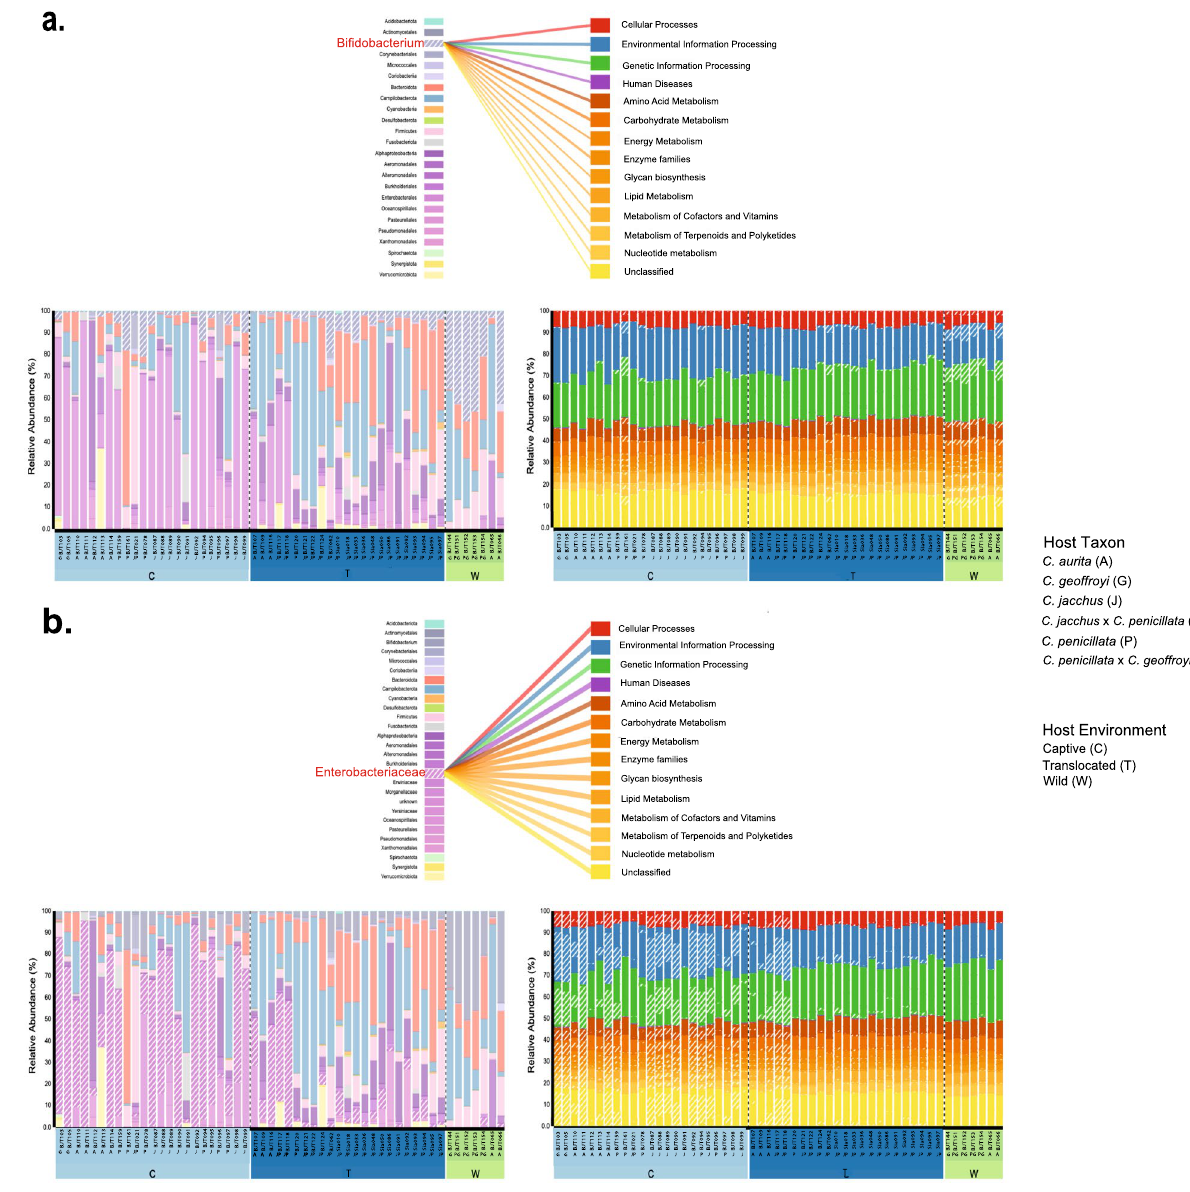
Figure 6. Visualization of BURRITO results showing linkage between Callithrix gut bacterial taxa composition and predicted functional profiles. In each plot, the lower left corner shows bacterial taxa relative abundance and the lower right shows predicted relative abundances of major functional categories of the Callithrix gut. The middle upper portion of each plot shows distribution of involvement of specific bacterial taxa in functional processes. Thickness of connecting lines between bacterial classes and functional classes indicates stronger involvement of a given bacterial taxon in a given functional process. The position of bacterial taxa and functional processes among respective relative abundance plots is represented by diagonal stripes. Host environment classifications in all plots are classified by C = Captive, T = Translocated, and W = Wild. ( a ) Distribution of Bifidobacterium role (highlighted in red) in predicted functional processes, with expansion of metabolic processes. ( b ) Distribution of Enterobacteriaceae role (highlighted in red) in predicted functional processes, with expansion of metabolic processes. Legend of host classifications are shown to the right of the